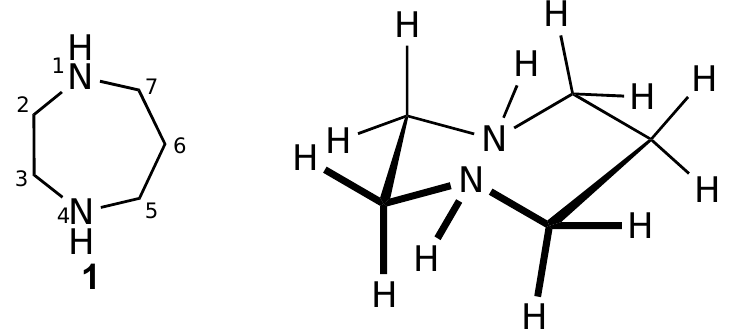
Figure 1. Molecular structure of 1 with anisotropic displacement ellipsoids drawn at 50% probability level and showing numbering system used. Bond lengths and angles: N(1)–C(2) 1.455(5), C(2)–C(3)